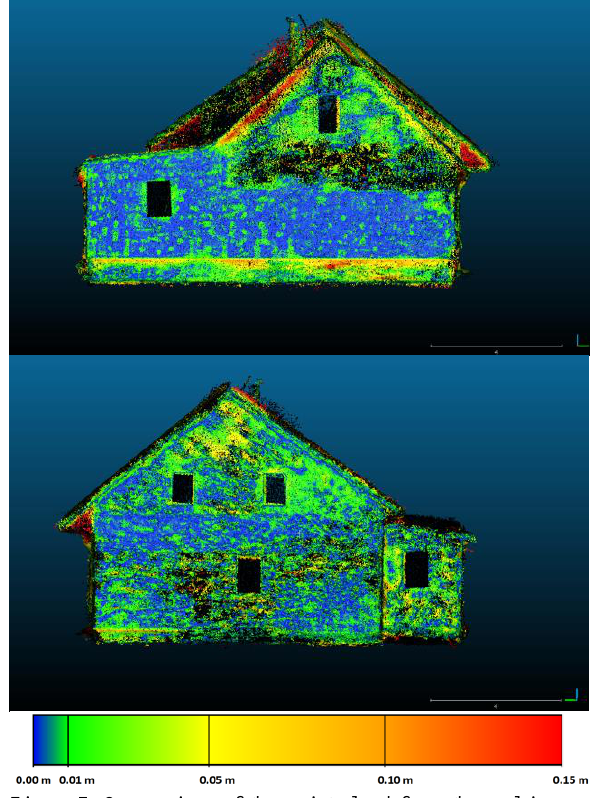
Figure 7. Comparison of the point cloud from thermal images and Leica BLK360 laser